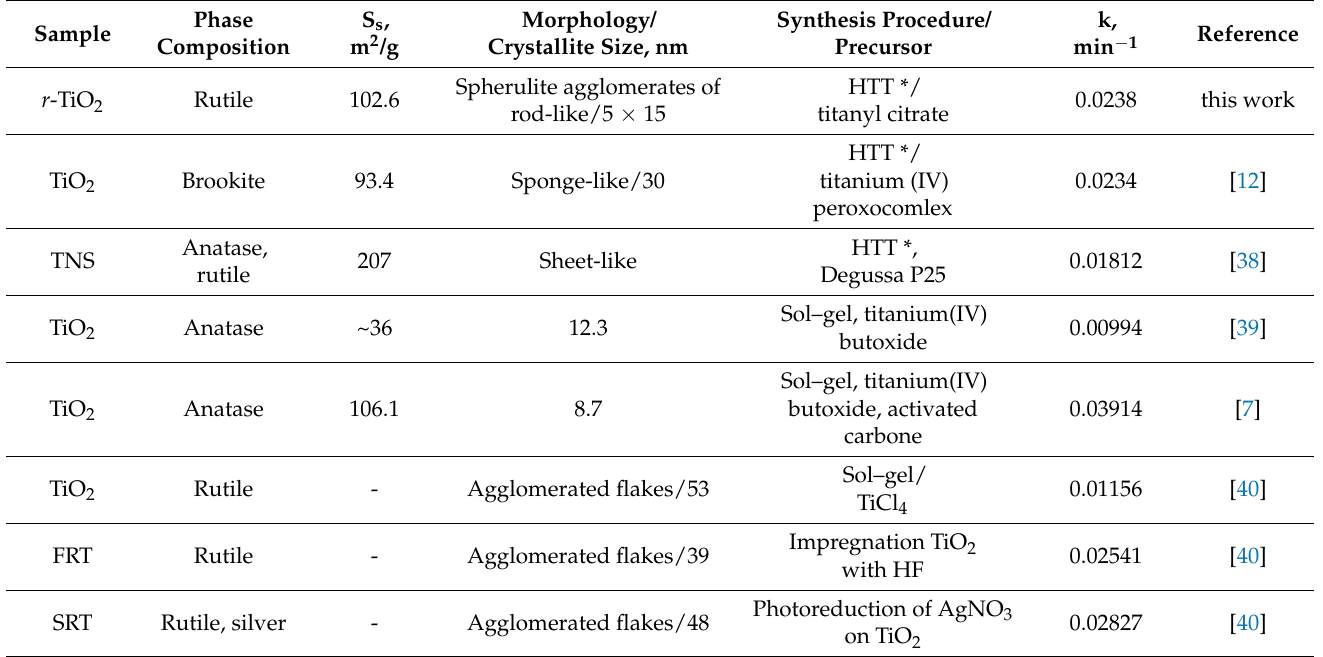
Table 1. Structural characteristics of different photocatalysts, their synthesis background, and photo- catalytic